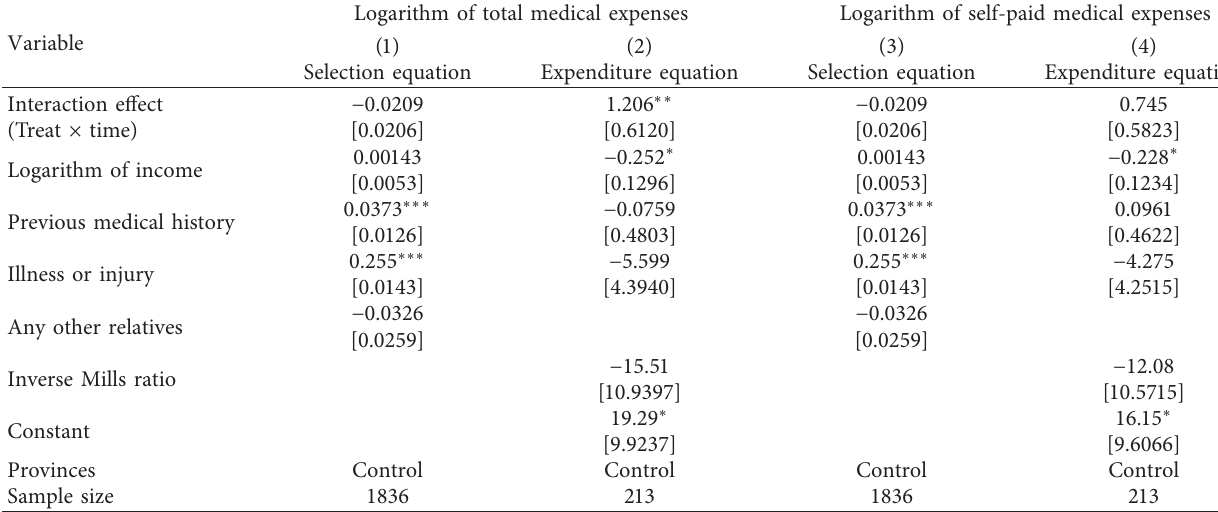
Table 4: Empirical results of Heckman sample selection